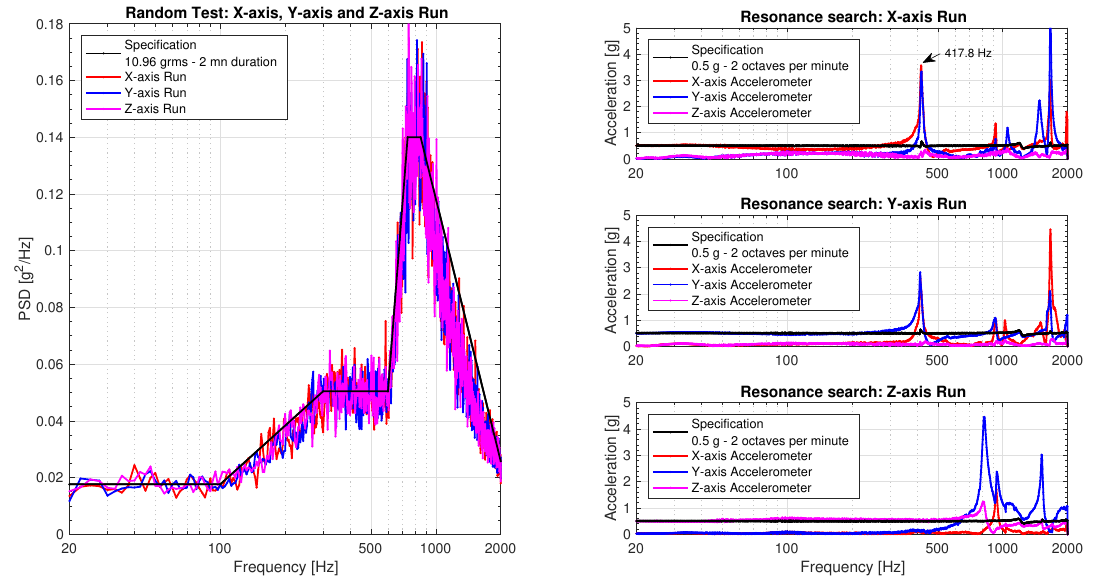
Figure 3. ( Left ) Random vibration profile was run in three orthogonal axes, referred as X, Y, Z. ( Right ) Resonance search carried out on UVSQ-SAT before and after each random run (September 2020).